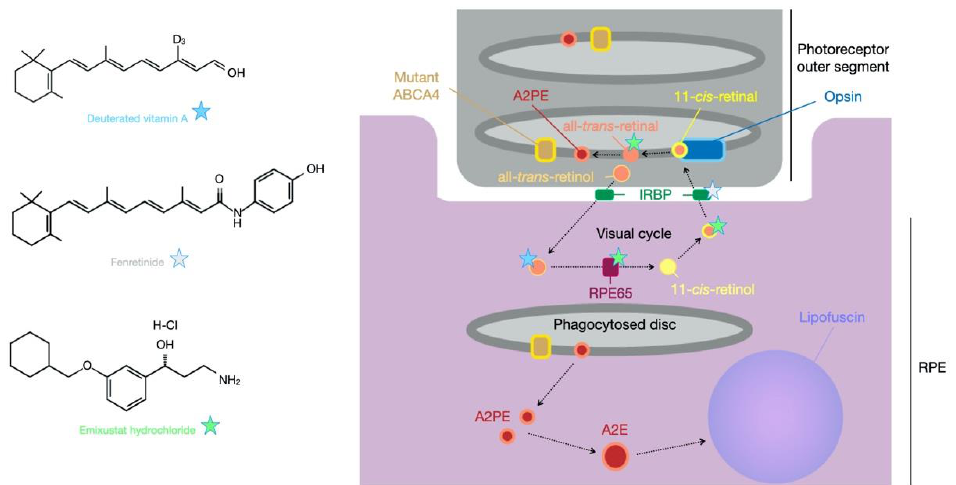
Figure 2. Example pharmaceutical interventions for Stargardt disease. Treatment strategies for STGD1 include pharma- ceutical products that interfere with the biochemical pathways that lead to the disease state. IRBP = interphotoreceptor retinoid-binding protein; RPE = retinal pigment epithelium; RPE65 = retinoid isomerohydrolase.